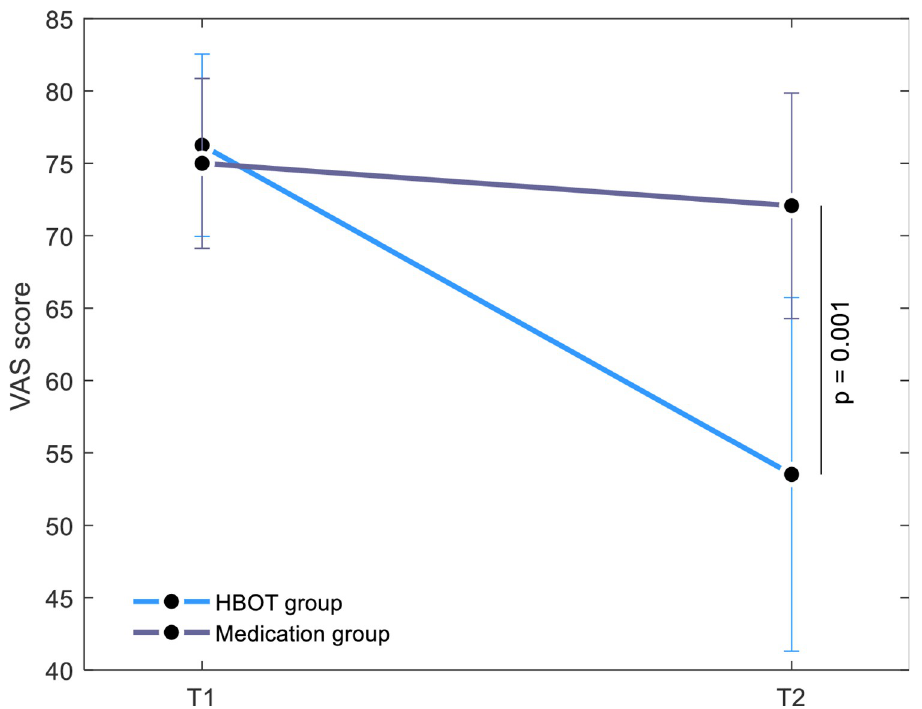
Fig 2. VAS score changes in the HBOT and medication groups. Model estimated marginal means and 95% confidence intervals. Significant three-months interaction effect, p =